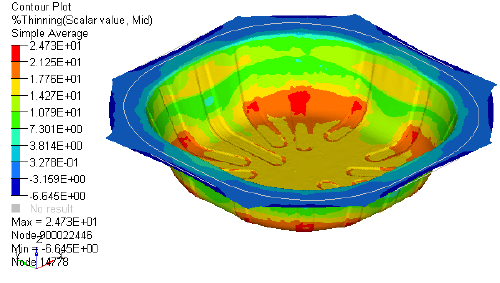
Figure 3. Forming limit diagram (FLD) for RUN0.